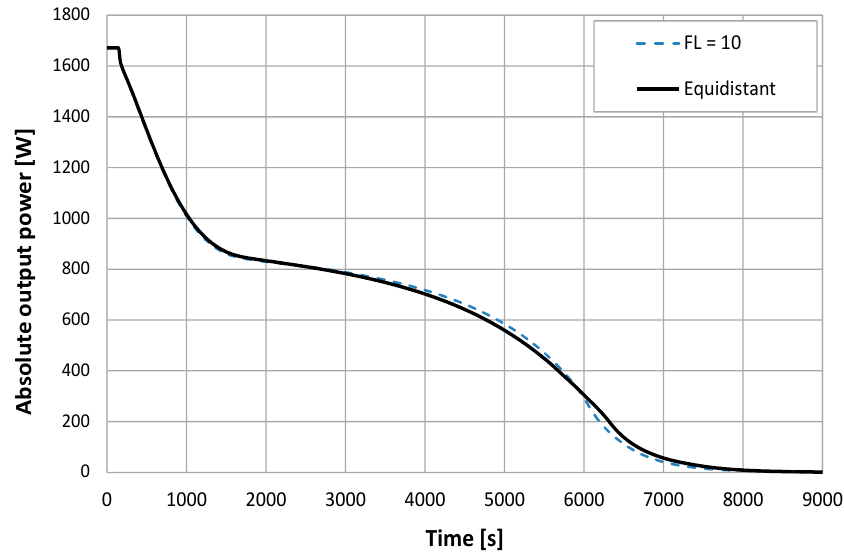
Figure 6. Storage performances of two simulated allocations of fins.